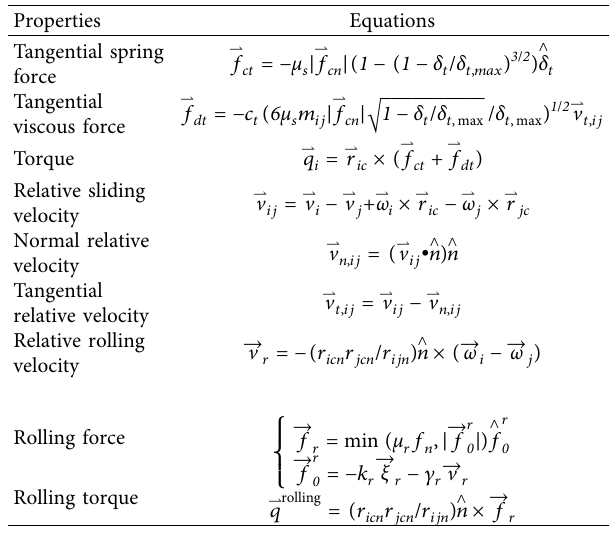
Figure 10: Collision process of two ellipses. The smaller ellipse is particle i and the bigger one is particle j . (a) Initial positions. (b) Final positions. (c) Process of collision. (d) Local zoom. Table 4: Forces and torques between